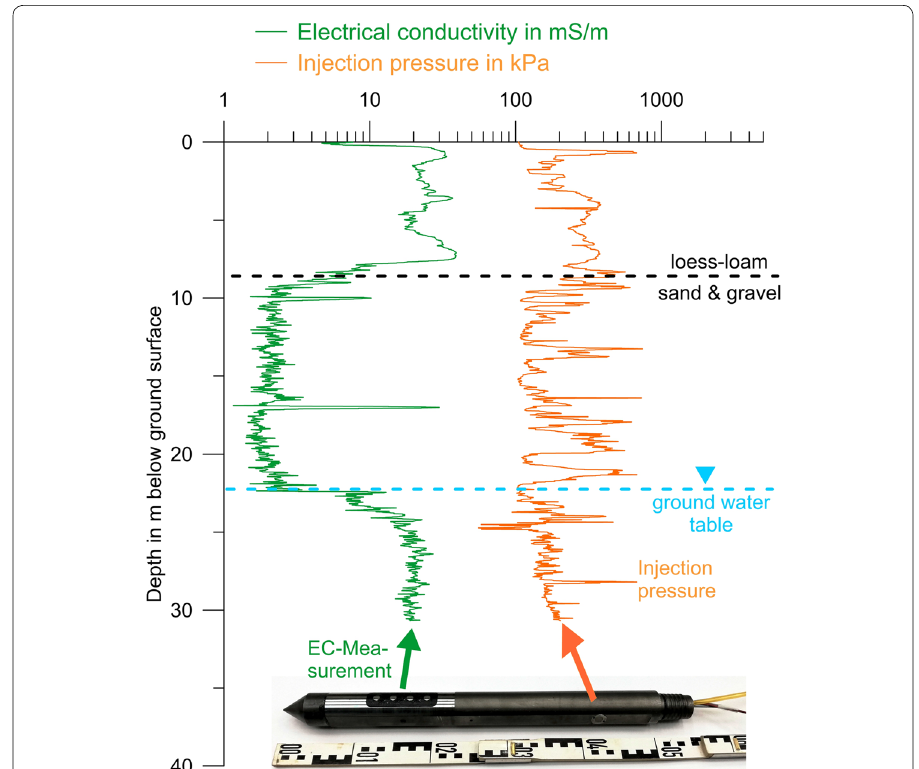
Fig. 2 Overview of the employed direct push probe and direct push hydraulic profiling and electrical conductivity logging results at well location